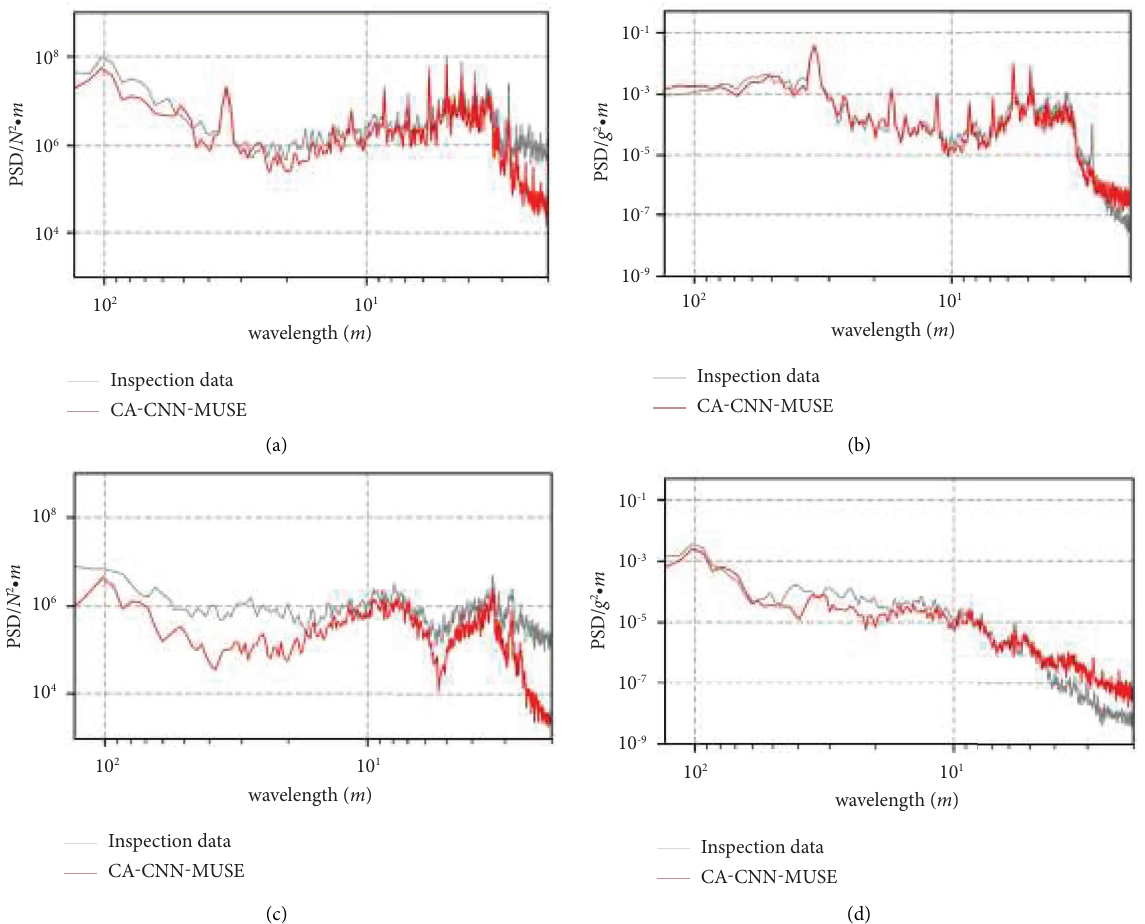
Figure 4: PSD of vehicle responses. (a) Right vertical force, (b) vertical car body acceleration, (c) right lateral force, and (d) lateral car body